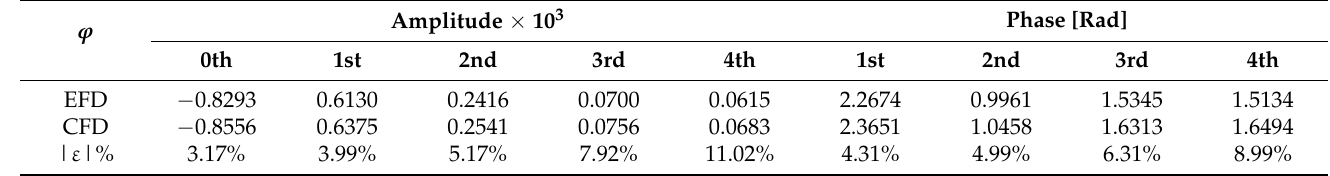
Table 12. Harmonic amplitudes and phases of roll ( ϕ ) for the FRxz ϕθ bow waves scenario.